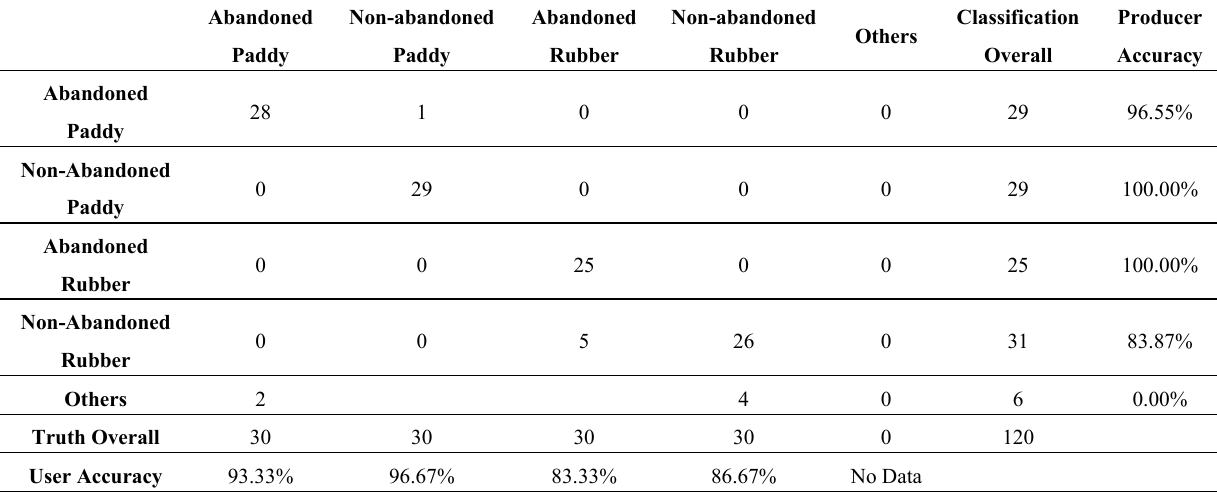
Figure 7. Paddy feature extraction using time-series images and historical image. Table 3. Accuracy assessment for abandoned and non-abandoned paddy and